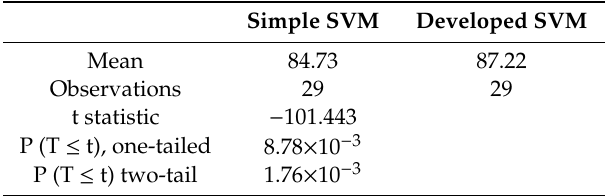
Table 3. T -Test: Simple SVM and developed SVM sample for the